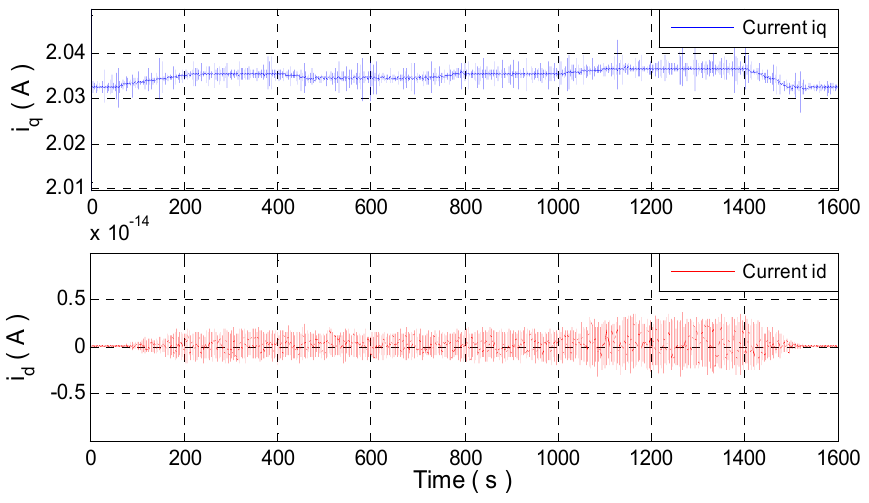
Figure 4. Current i q and current i d .